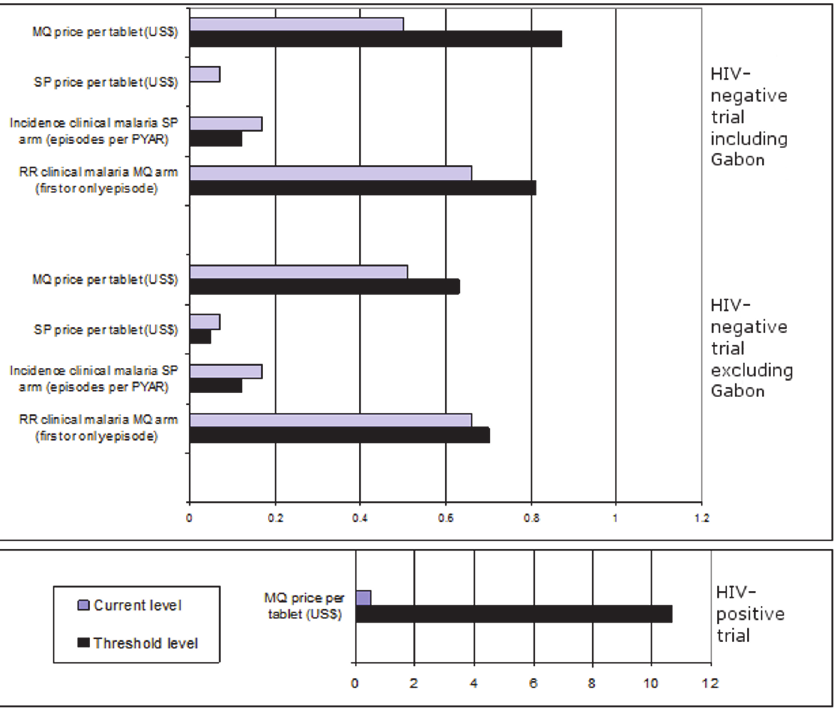
Fig 7. Results of the threshold analysis of IPTp-MQ among HIV-negative and HIV-positive pregnant women. IPTp = Intermittent Preventive Treatment of malaria in pregnancy; HIV = Human Immunodeficiency Virus; MQ = Mefloquine; SP = Sulphadoxine-Phyrimethamine; PYAR = Person-year at risk; RR = Relative Risk. The graph depicts up to which level (threshold level) several variables can increase or decrease from their current level for the interventions to remain